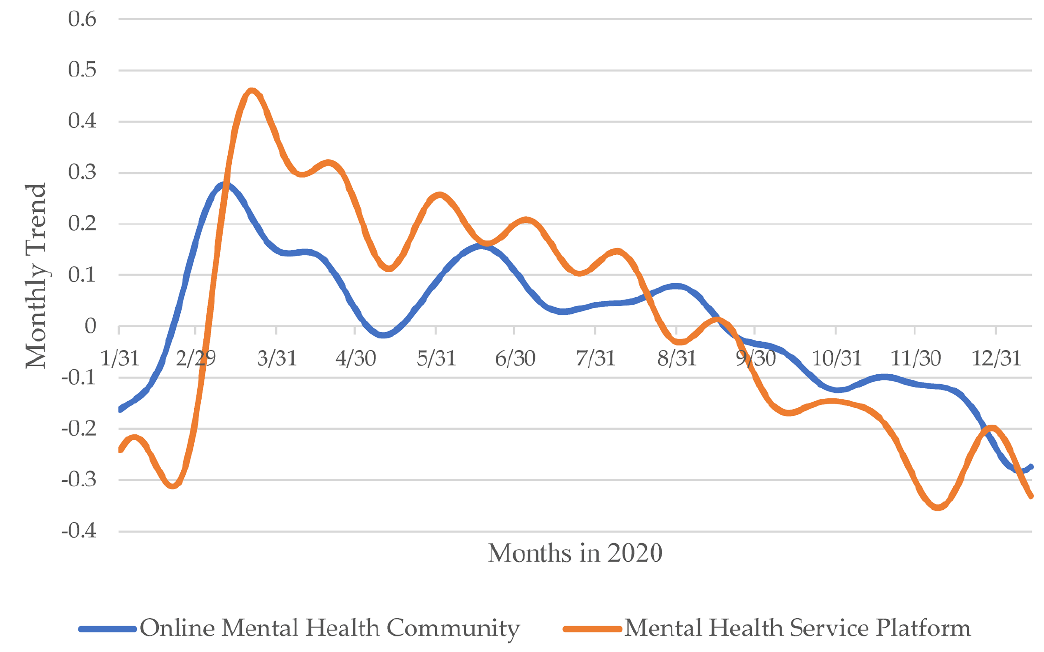
Figure 6. The monthly trends for the number of PHS posts on two OMHS platforms during the COVID-19 pandemic. Table 3. Correlations between the COVID-19 cases and the number of PHS posts due to different symptoms. COVID-19 Cases